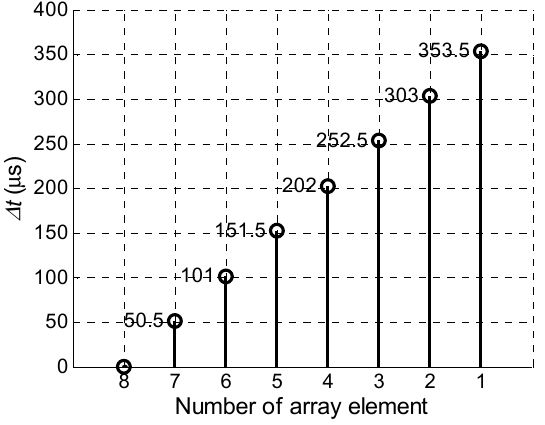
Figure 10. Linear delay scheme of the array excitation signals, when the delay time is increased by Δt = 50.5 µs step.